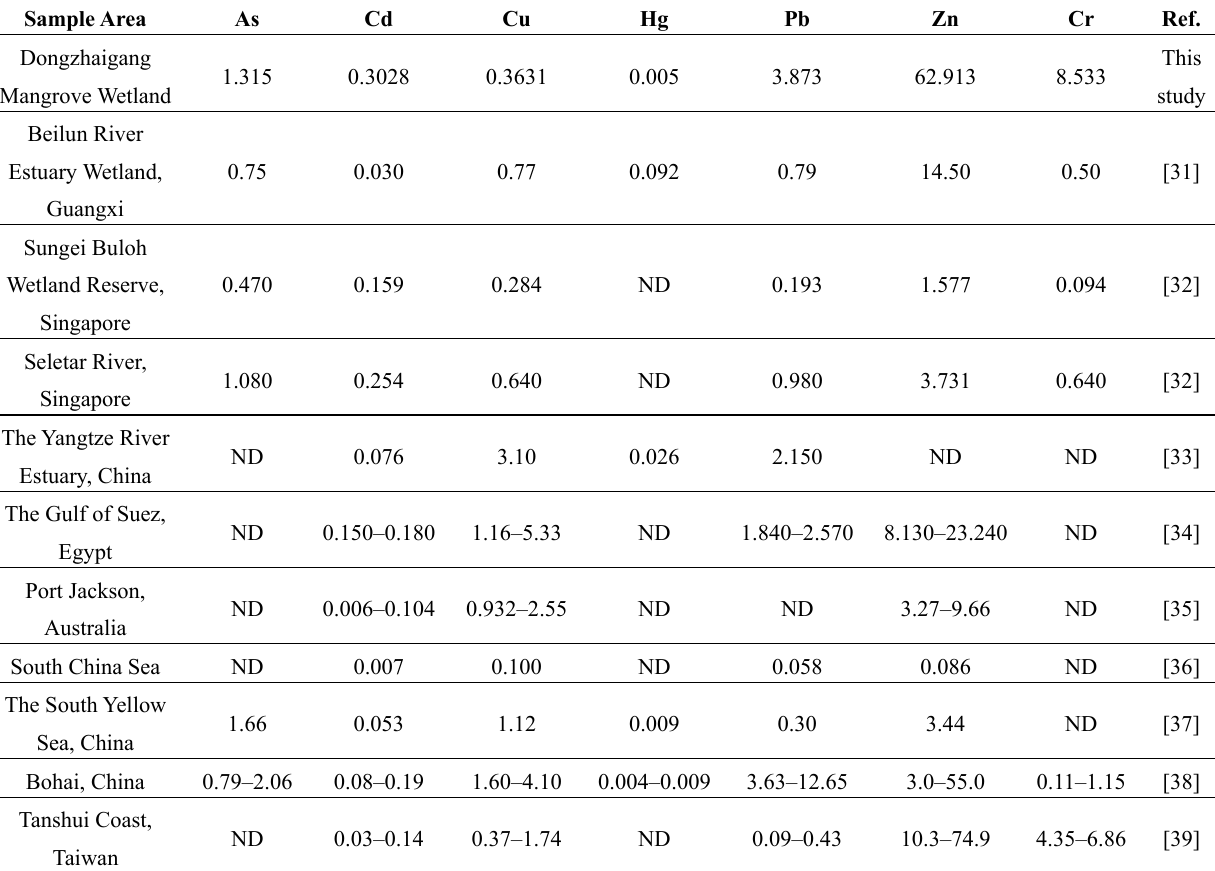
Table 4. Comparison of heavy metal accumulation in the surface seawater with the reported values in the literatures ( μ